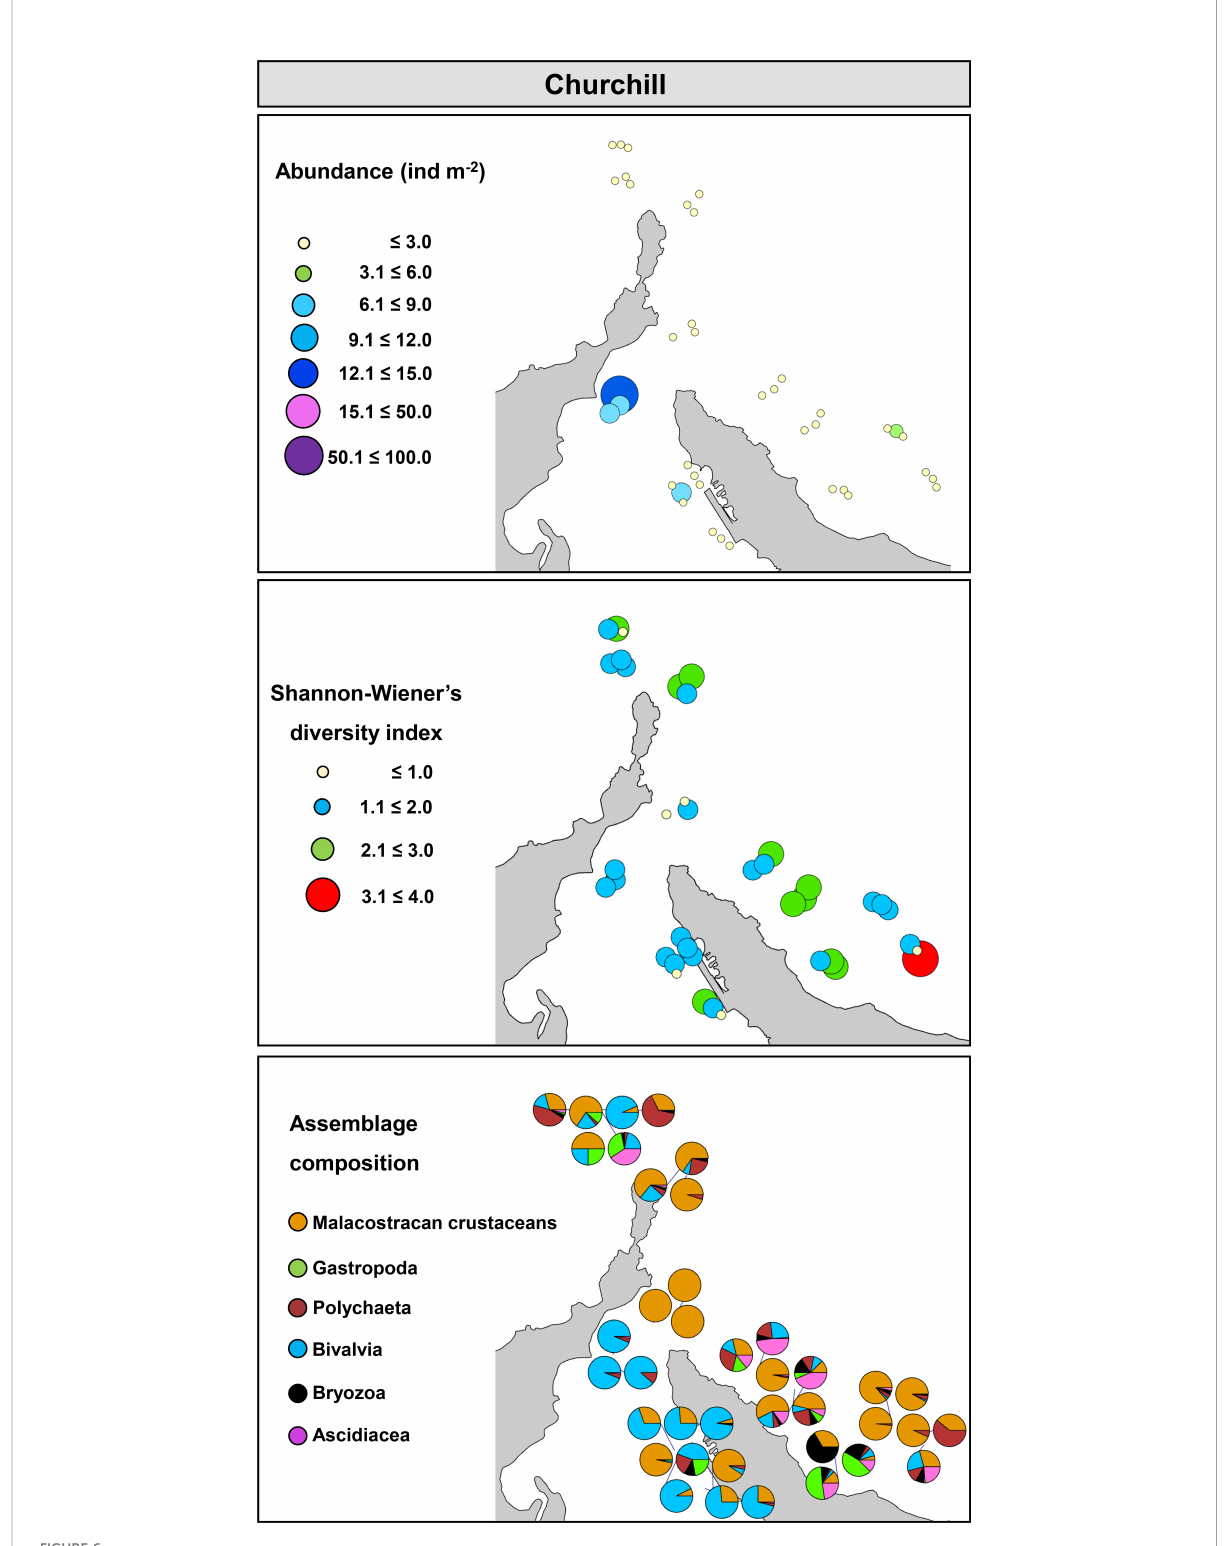
FIGURE 6 Community metrics and assemblage composition in Churchill,